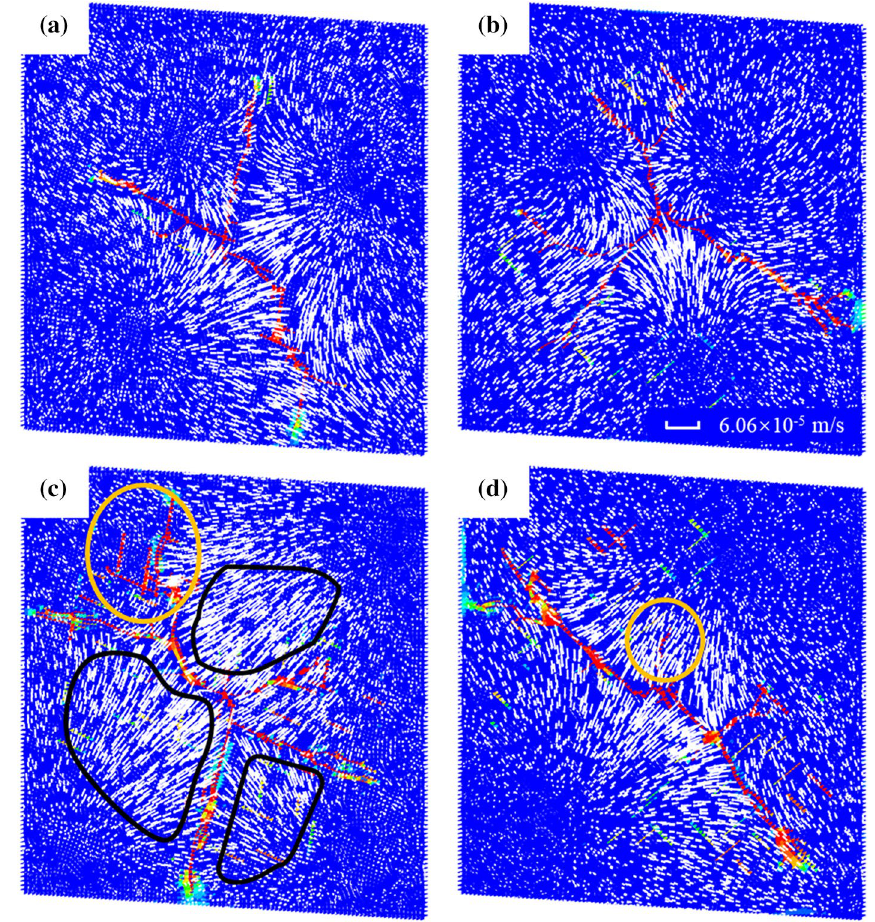
Fig. 11 The flow trajectory of the fluid under the four groups of crack nets. White vectors represent the